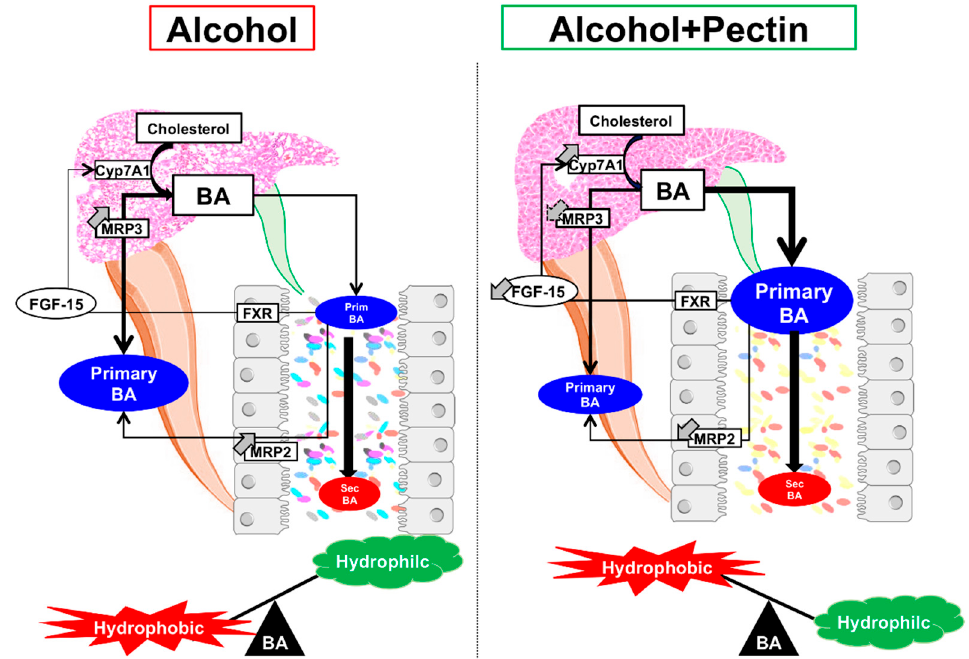
Figure 9. Graphical summary of the role of pectin in the bile-acid (BA) enterohepatic cycle in alcoholic liver disease. Pectin alleviates alcohol liver disease by increasing BA excretion and modifying the intestinal microbiota and the BA pool.